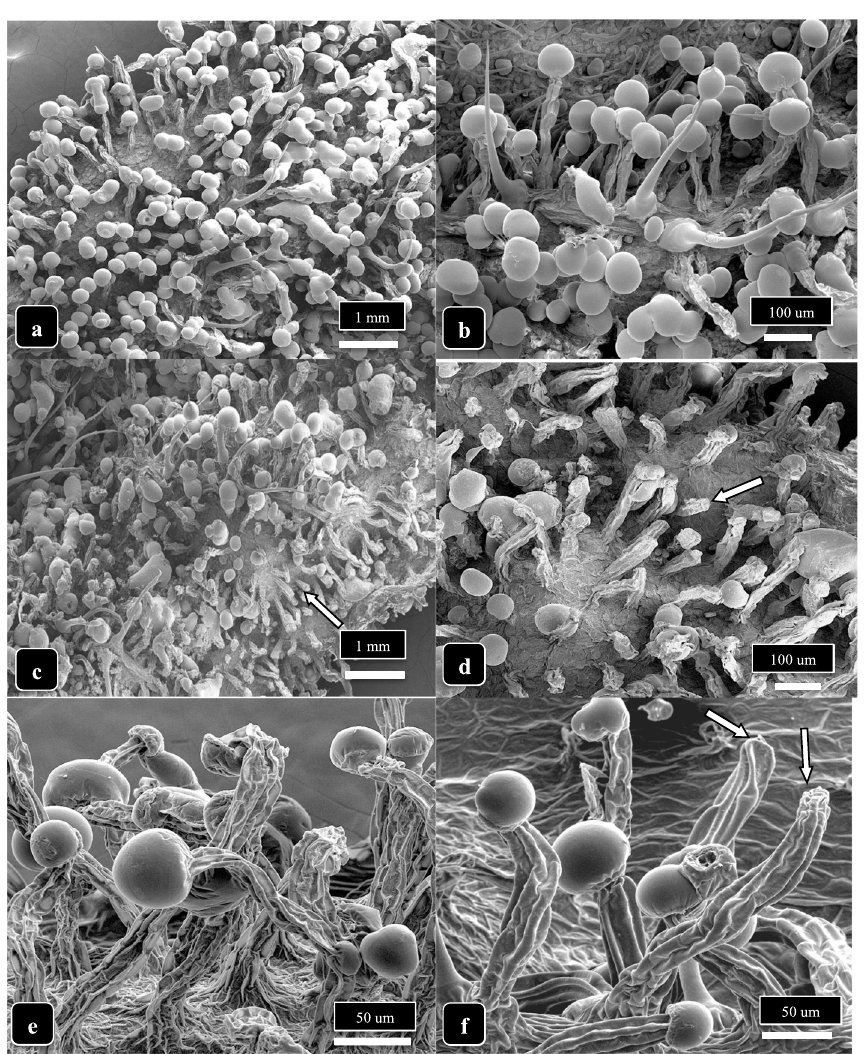
Fig. 14 The effect of post-harvest handling practice on capitate trichome integrity of cannabis genotype “Pink Kush.” a A sample that was hand-trimmed to remove the inflorescence leaves before drying shows the majority of trichomes are intact and glandular heads are present. b Close-up view of trichomes in a hand-trimmed sample showing all glandular heads are intact. c A sample that was mechanically-trimmed to remove the inflorescence leaves shows a loss of trichomes and many heads have become detached (arrows). d Close-up view of trichomes in a mechanically trimmed sample showing many glandular heads are broken off or shriveled (arrow), especially at the edges of the bracts. e , f The dried stalks after 5 days of drying at 50–55% relative humidity show the outlines of the epidermal/hypodermal cells that make up the stalk. Most glandular heads are intact; a few have broken off (arrows). The cuticle is intact